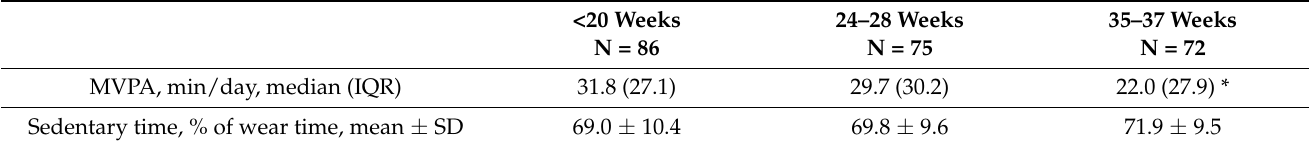
Table 2. Moderate-to-vigorous physical activity (MVPA) and sedentary time at three time points in